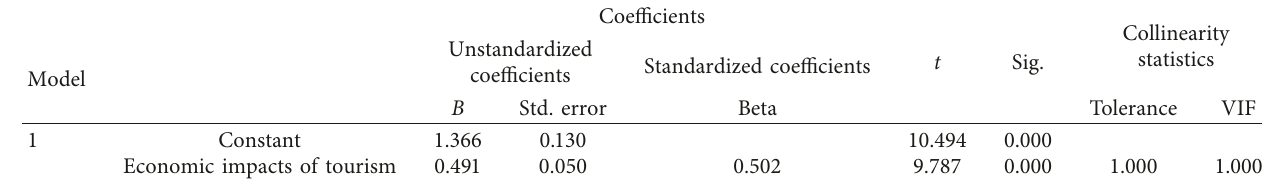
Table 6: Coefficient of determination: urban poverty